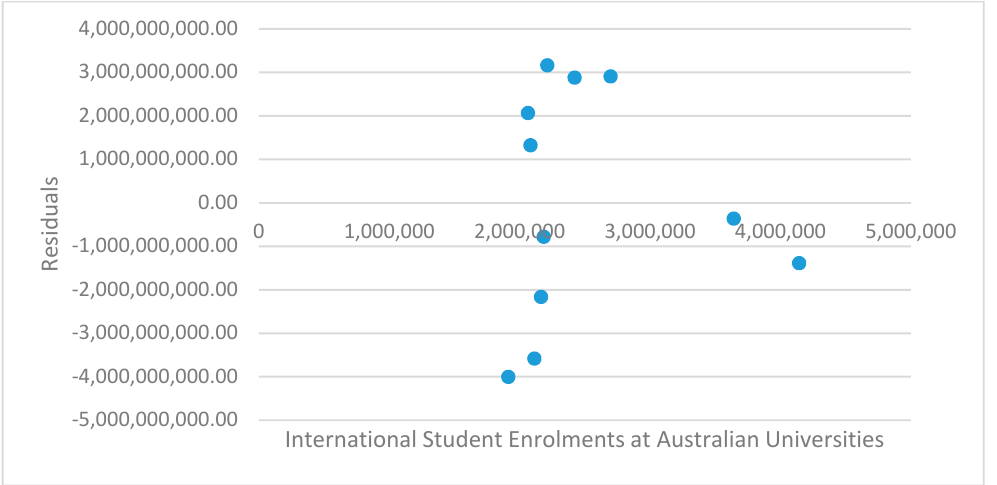
Figure 3. Residual Plot for Full-Time Equivalent (FTE) Employment and Total Australian University Revenue.